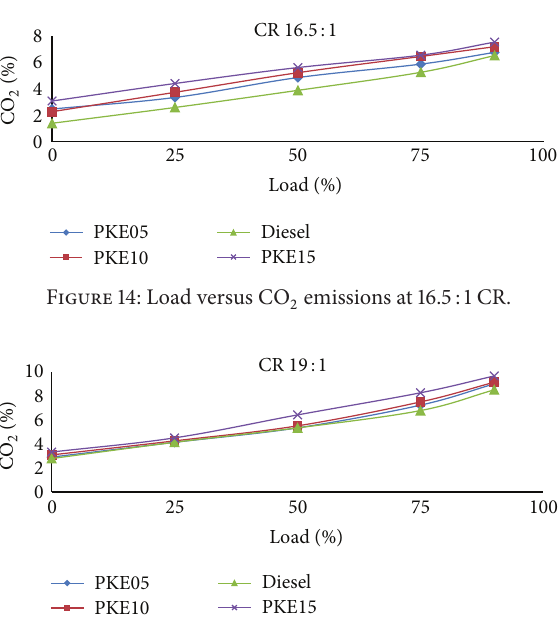
Figure 8: Load versus exhaust gas temperature at 16.5 :1 CR.